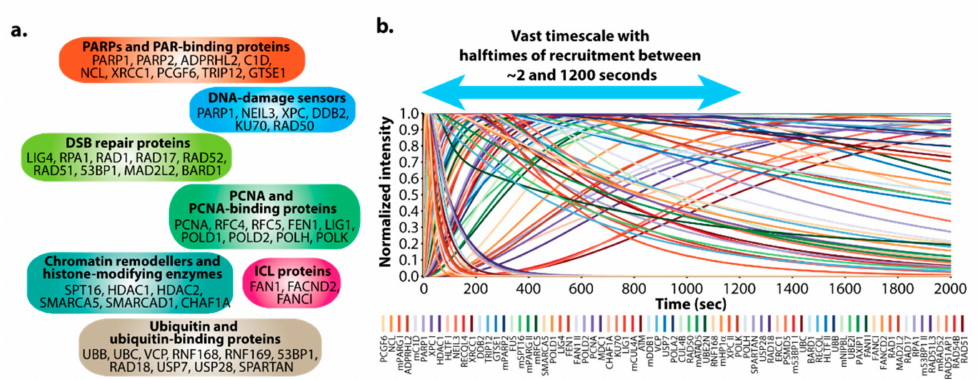
Figure 2. DNArepairK provides a unique dataset for exploring the dynamics of the DNA damage response. ( a ) DNArepairK dataset encompasses proteins implicated in all DNA repair events in human cells. ( b )The DNArepairK dataset provides an almost complete chronology of the events during complex DNA damage